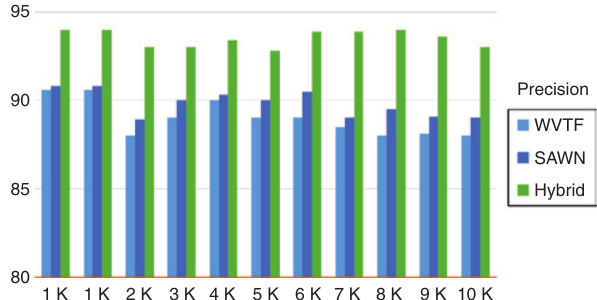
Figure 5: Evaluation of the CBER Approach in Terms of Precision.